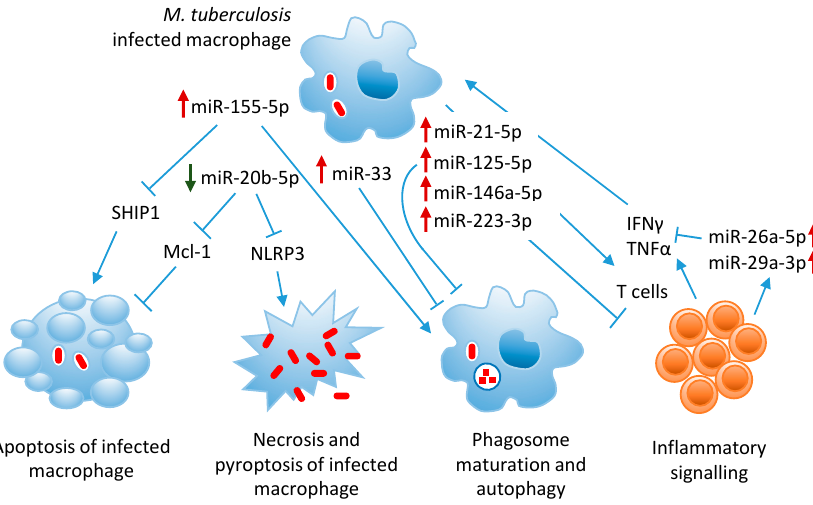
Figure 2. Graphical representation of miRNA regulation of host immune responses against M. tuberculosis infection. MicroRNAs that are up-regulated or down-regulated during M. tuberculosis infection are indicated with red and green arrows, respectively.